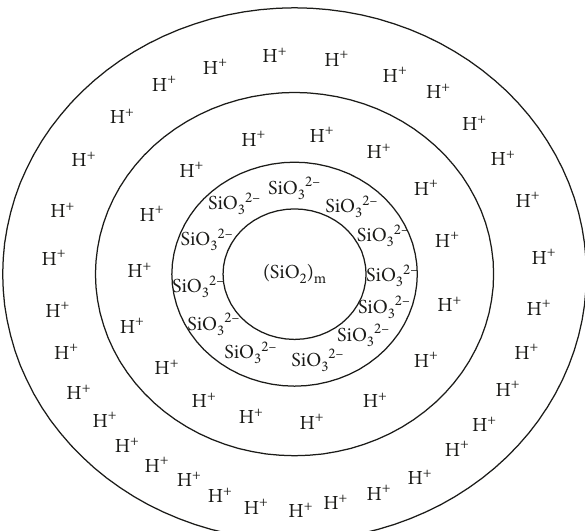
Figure 8: Schematic diagram of SiO